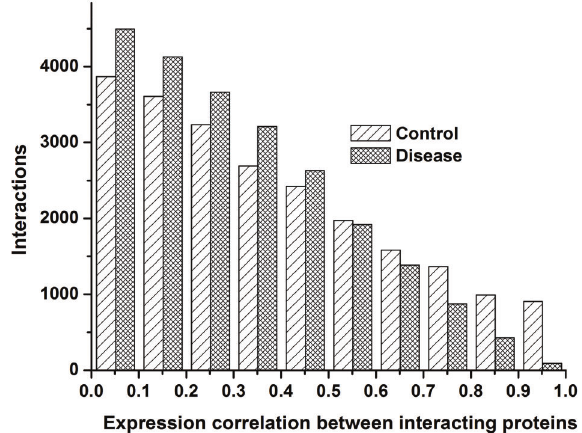
Figure 2. Frequency distribution of maximal cliques in the nasopharyngeal carcinoma group and the control